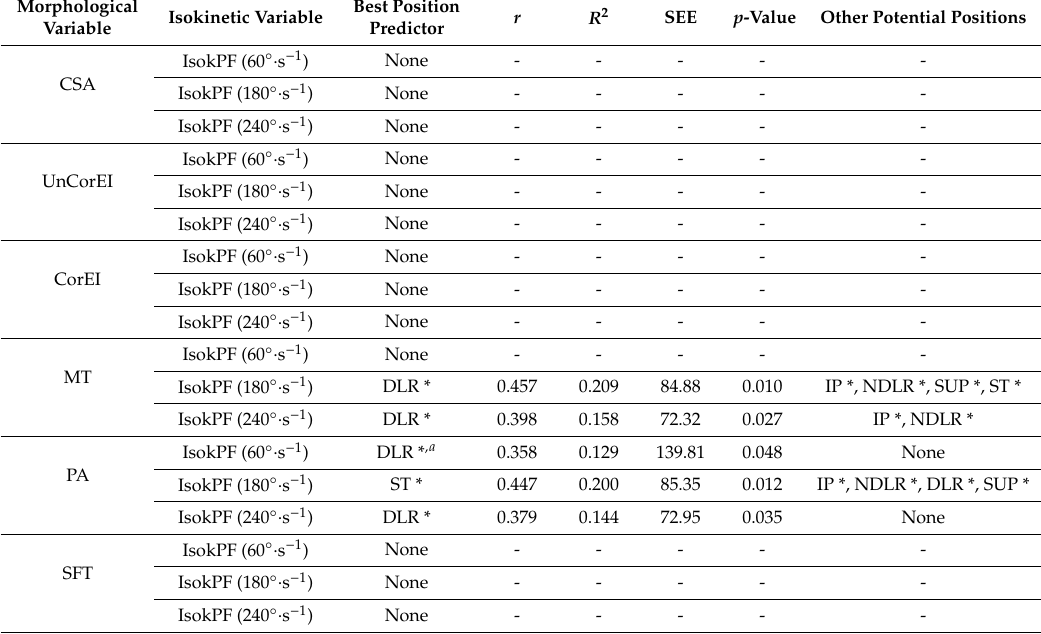
Table 6. Associations between muscle ultrasound-derived muscle morphological characteristics after rest in di ff erent positions and isokinetic variables after correcting for Biodex dynamometer arm length. Morphological